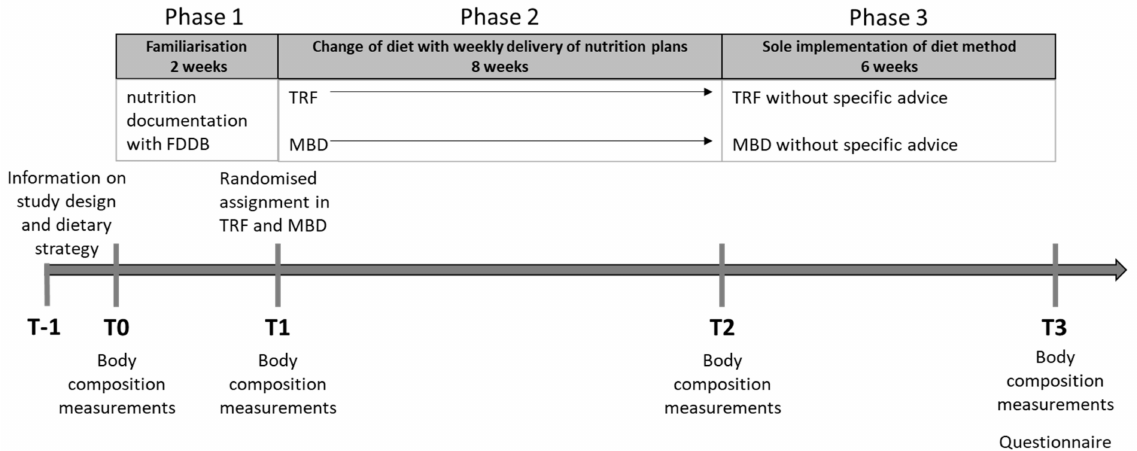
Figure 1. Study design of the intervention with three different phases. Phase 1: Familiarisation with nutrition documentation; phase 2: nutritive investigation (TRF or MBD) with specific support; phase 3: sole implementation of diet method without specific advice. Abbreviation: MBD = macronutrient-based diet; TRF = time-restricted feeding; T = time